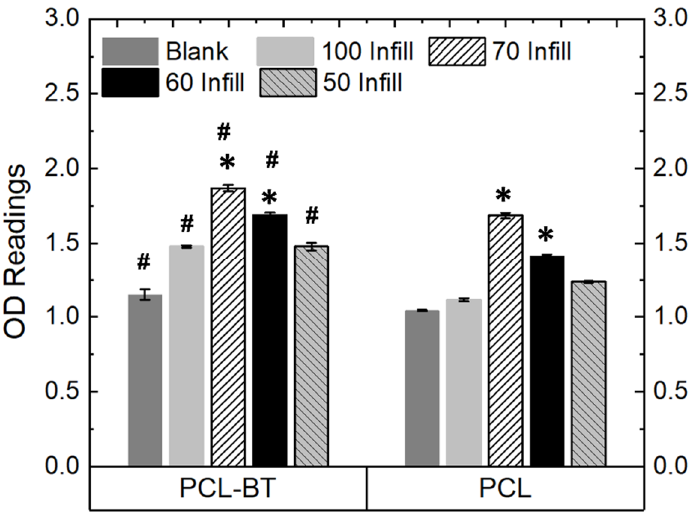
Figure 12. OD readings of MC3T3 cells cultured on the piezoelectric scaffolds (PCL-65BT) with different infill (pore sizes); 1 MHz US was used per the routine for all the proliferation tests. * means statistically significant ( p < 0.05) with respect to the controls (Blank and 100 Infill specimens) in the same group. # means statistically significant ( p < 0.05) with respect to the PCL specimens with different